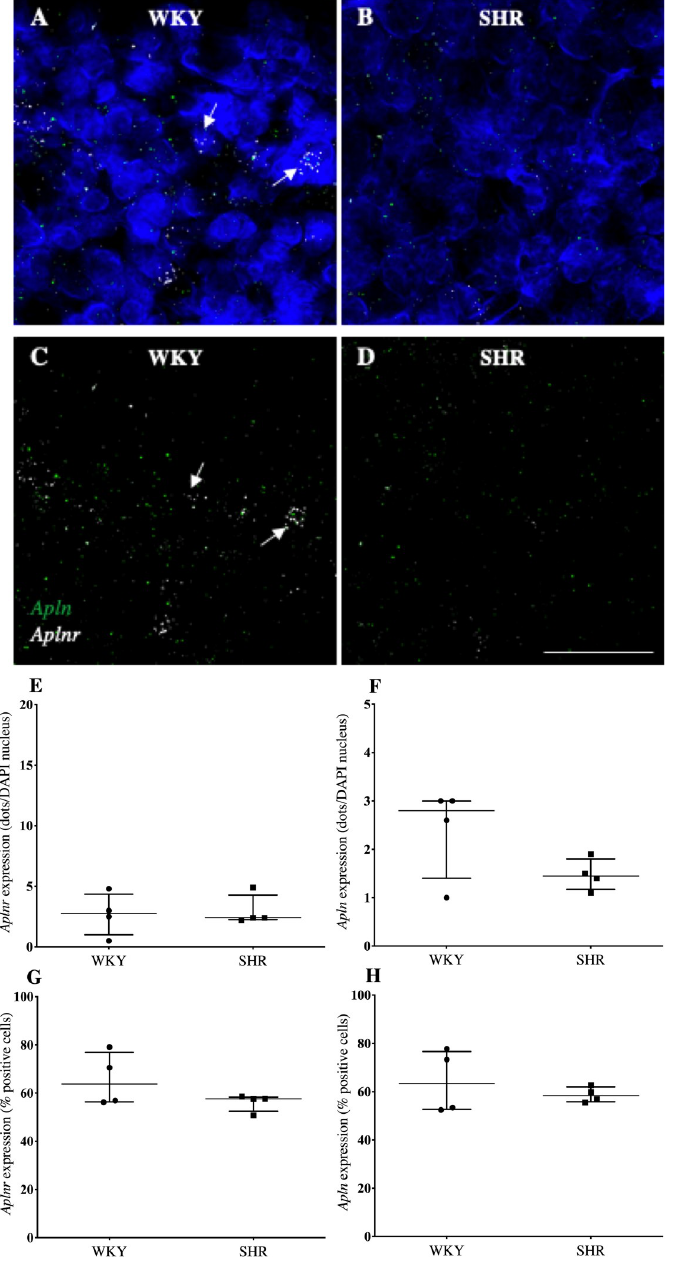
Fig 3. Aplnr and apln expression in the AP of WKY rats and SHRs. (A-D) Representative fluorescent images showing expression of aplnr and apln in the AP of WKY rats (A and C) and SHRs (B and D). DAPI: blue, aplnr : white, apln : green. DAPI removed from C and D to highlight distribution of mRNA. Cells with a high relative abundance of aplnr are arrowed. Scale bar = 50 μ m. (E-H) Graphs showing gene expression as a function of dots/DAPI nuclei or percentage positive cells for aplnr (E and F) and apln (G and H) mRNA. n = 4/group. Data is median [IQR].